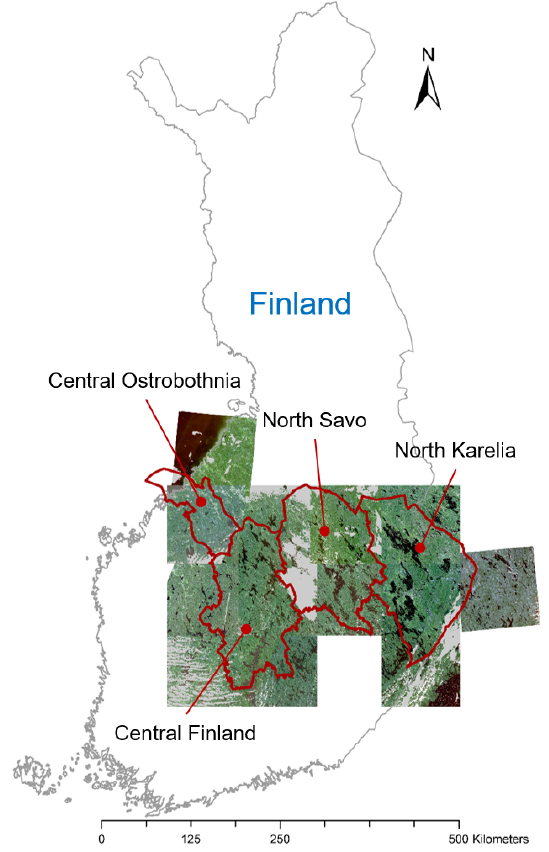
Figure 1. The study area in Central Finland with the 22 Sentinel-2 images overlaid, and the four forestry districts delineated in red. The total area of the four districts is 68,315 km 2